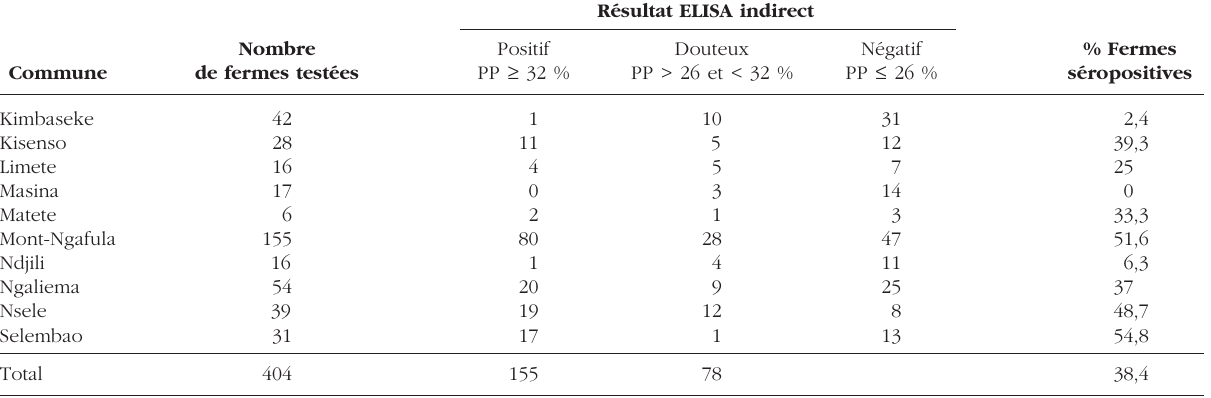
Tableau II. – Résultats des tests sérologiques réalisés dans les fermes de différentes